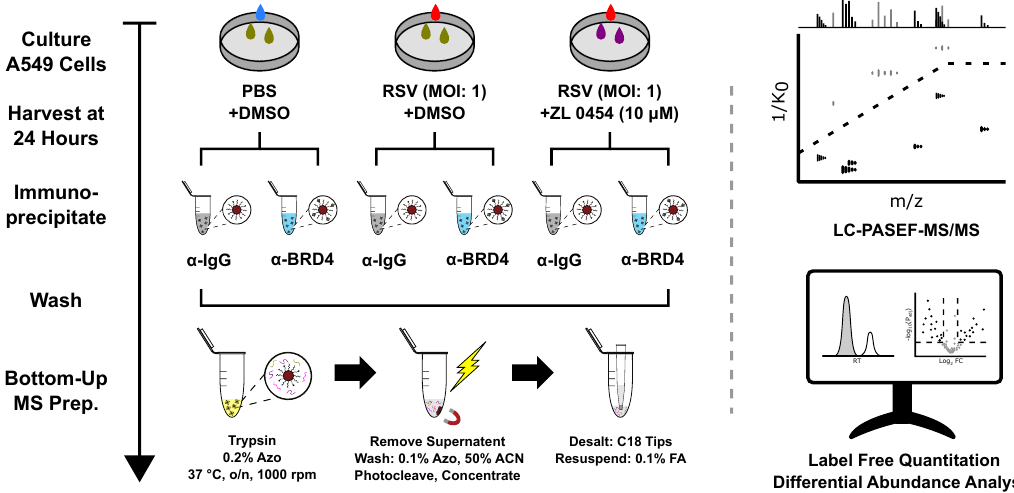
Figure 1. Affinity Purification Mass Spectrometry (AP-MS) experimental workflow, including sample preparation and data analysis. In brief, A549 cells were grown to confluence, treated with the bromodomain inhibitor ZL0454, and infected with RSV. Cells were harvested in a non-denaturing lysis buffer and BRD4 complexes were immunoprecipitated with anti-BRD4 or Isotype Control (IgG) antibodies and protein A magnetic beads. After extensive washing, the isolated proteins were digested on-bead using trypsin in a photocleavable surfactant (Azo) buffer [22,23]. After surfactant removal, the samples were desalted using C18 tips and analyzed via online LC-PASEF-MS/MS. Peptide identification and protein quantification were performed in MaxQuant. Differential abundance analysis was performed using DAPAR and